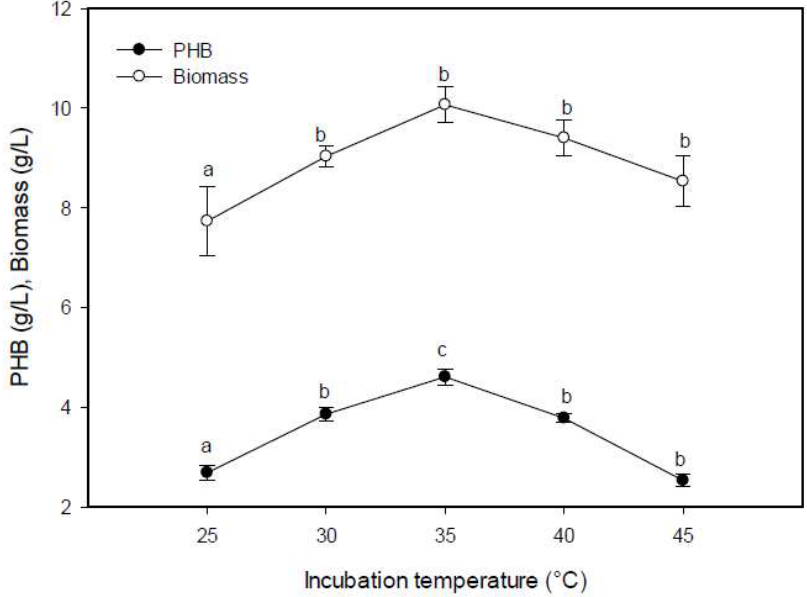
Figure 6. Effect of incubation temperature on the PHB production by E. aquimaris . The values set by oneself letter(s) on the same line were not significantly different. oneself letter(s) on the same line were not significantly di ff